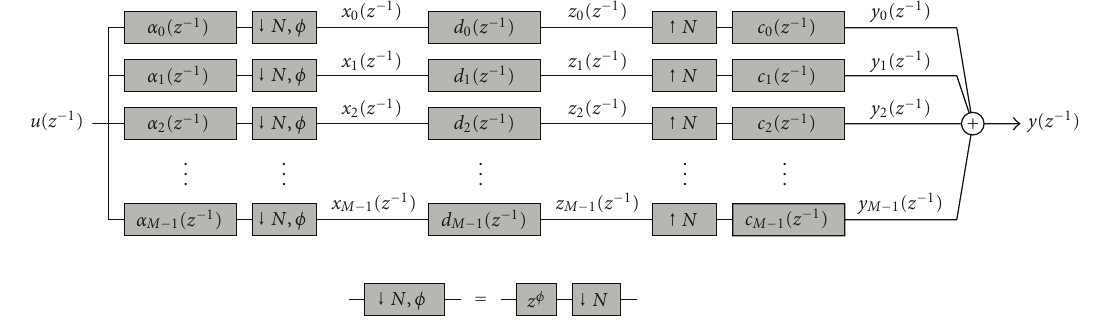
Figure 1: Overlap-add filter bank with M bands and N -fold